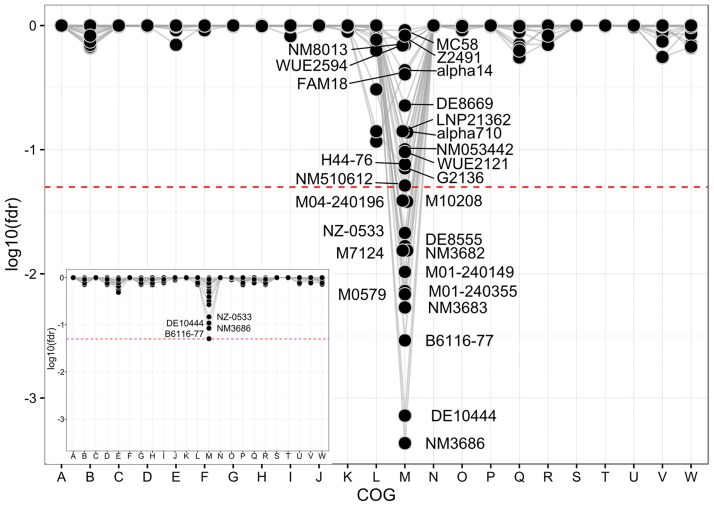
COG enrichment analyses of SSR loci in 27 meningococcal genomes.Enrichment of the different COG functional classes (B-V) among the proteins encoded by SSR loci. In the main panel, SSR loci associated with repeats having a period length of (or multiple of) three were excluded prior enrichment analysis, while in the insert the complete set of SSR loci has been analyzed. The red dashed line indicates the significance threshold (fdr < 0.05). Since genes belonging to the COG class Y (Nuclear structure) are absent from the presented dataset it has been omitted from the figures as well as all genes that do not belong to any COG functional category (often referred to as COG X).COG abbreviations: B, Chromatin structure and dynamics; C, Energy production and conversion; D, Cell cycle control, mitosis and meiosis; E, Amino acid transport and metabolism; F, Nucleotide transport and metabolism; G, Carbohydrate transport and metabolism; H, Coenzyme transport and metabolism; I, Lipid transport and metabolism; J, Translation; K, Transcription; L, Replication, recombination and repair; M, Cell wall/membrane biogenesis; N, Cell motility; O, Posttranslational modification, protein turnover, chaperones; P, Inorganic ion transport and metabolism; Q, Secondary metabolites biosynthesis, transport and catabolism; R, General function prediction only; S, Function unknown; T, Signal transduction mechanisms; U, Intracellular trafficking and secretion; V, Defense mechanisms; W, Extracellular structures.